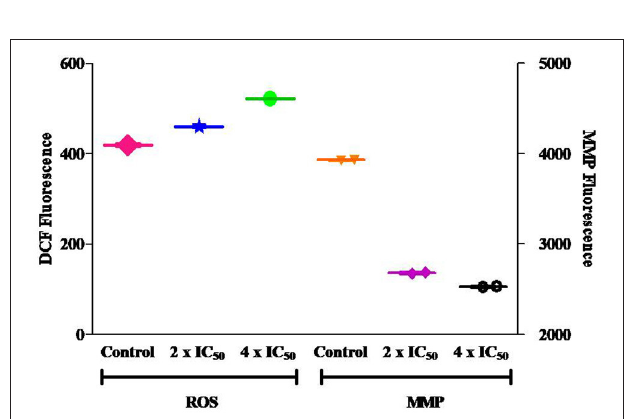
FIGURE 8 | Carvacrol non-significantly affect ROS and MMP in FaDu cells. One set of treated FaDu cells was stained with DCFDA dye, and another set was stained with rhodamine 123 dye, followed by analysis by flow